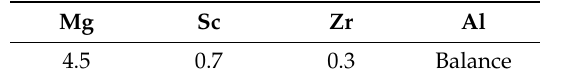
Table 1. Content (wt. %) of main alloying elements of the studied alloy.